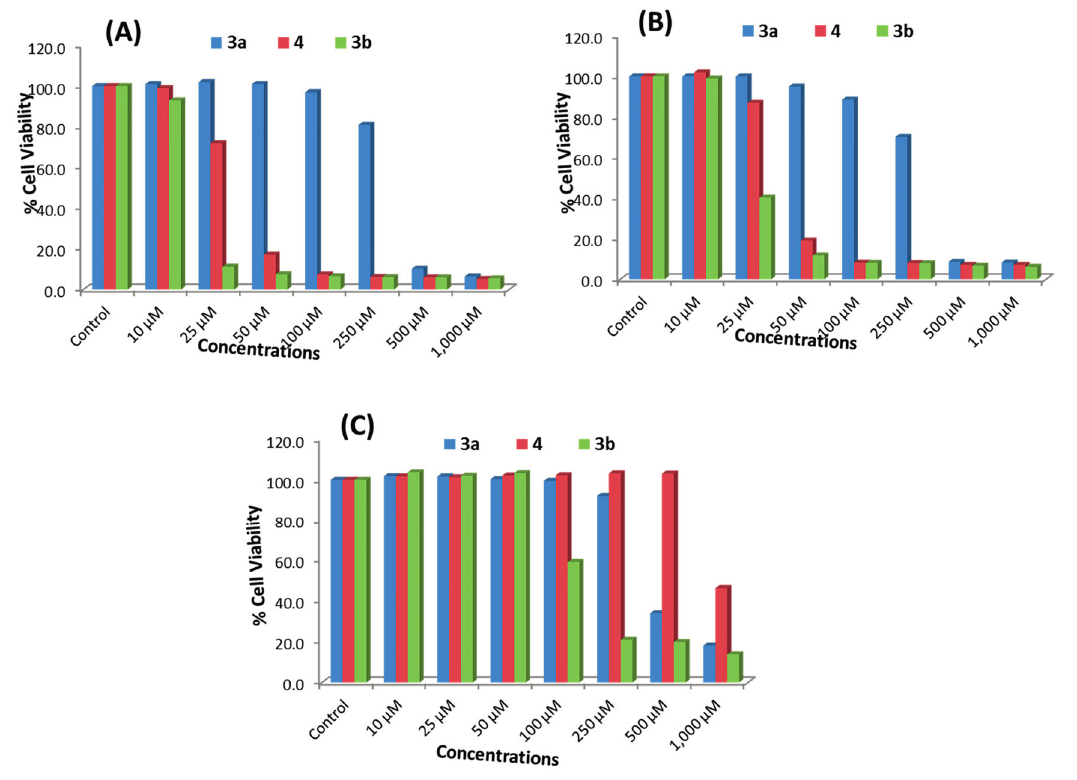
Figure 2. Cytotoxicity assessments by the neutral red uptake (NRU) assay in ( A ) MCF-7 cells, ( B ) HepG2 cells and ( C ) HEK293 cells. The cells were exposed to different concentrations of compounds 3a , 3b and 4 for 24 h. Values are the mean ± SE of three independent